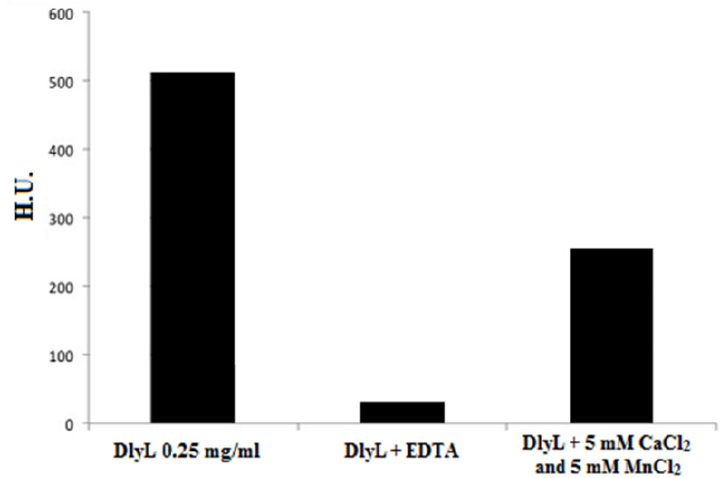
Figure 4. Metal dependence of DlyL. Hemagglutinating activity of native DlyL, demetalized DlyL (dialyzed against 100 mM EDTA, followed by 150 mM NaCl) and metal added to DlyL (5 mM CaCl and 5 mM MnCl ). 2 2